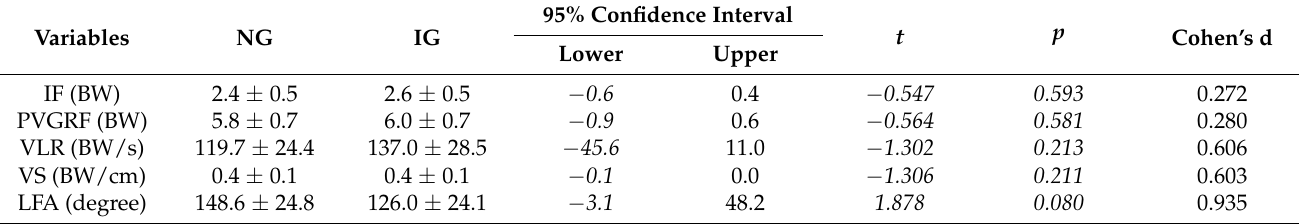
Table 1. Descriptive information for the impact variables and the landing foot angle.